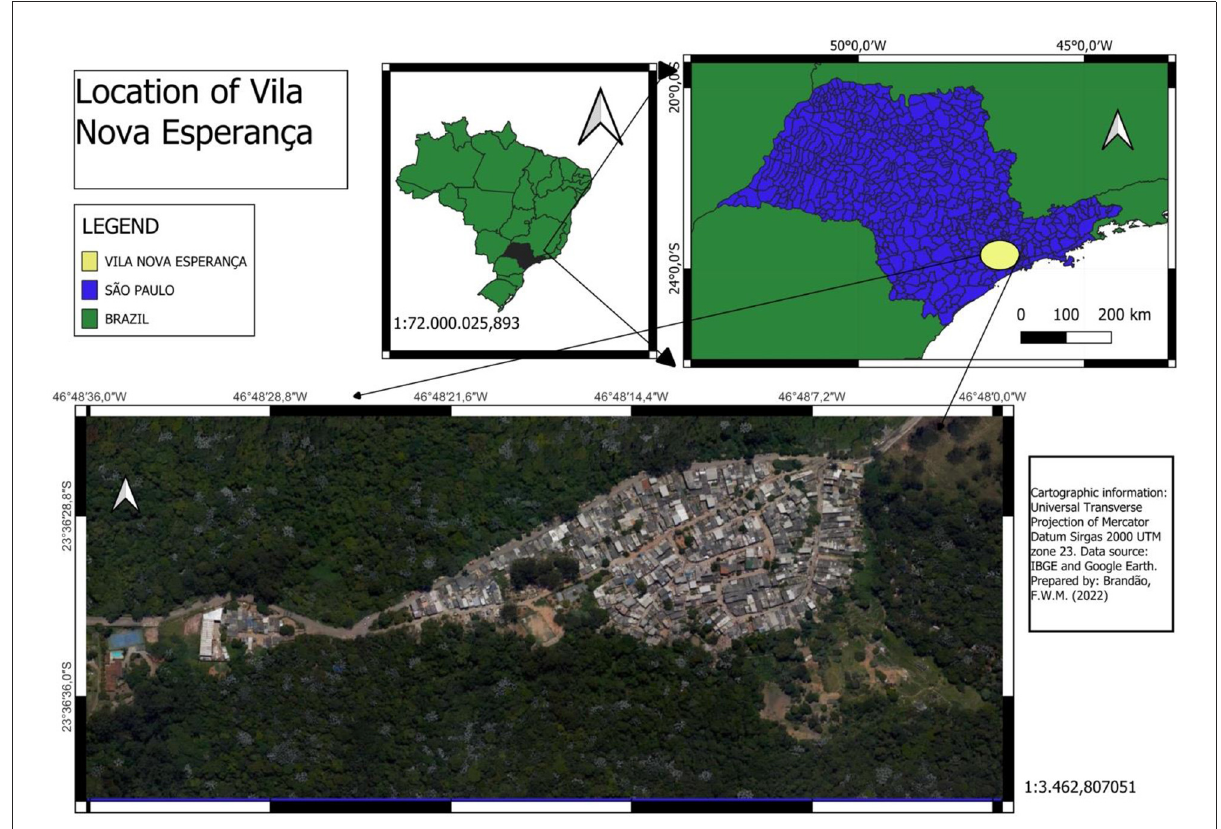
FIGURE2 Map of Vila Nova Esperança within the São Paulo State and Brazil. Map elaborated by F. W. M. Brandão